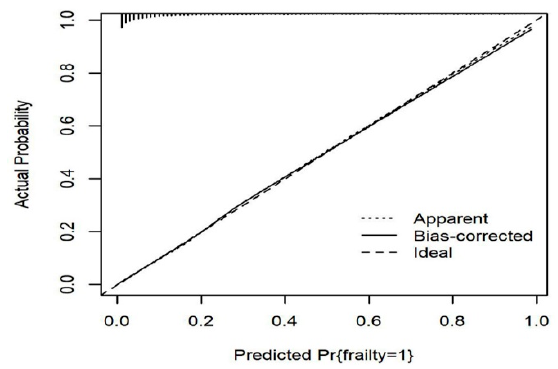
Figure 3. Calibration curve for the established nomogram.